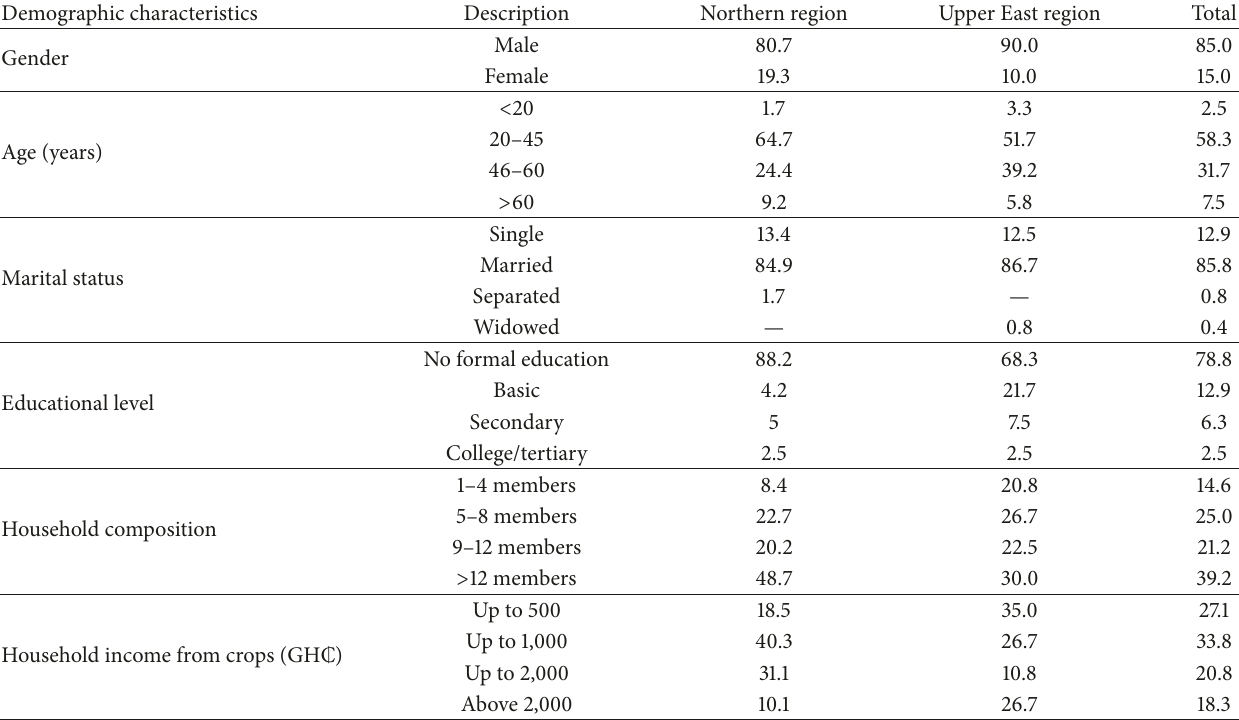
Table 1: Sociodemographic characteristics of the respondents (% responding).